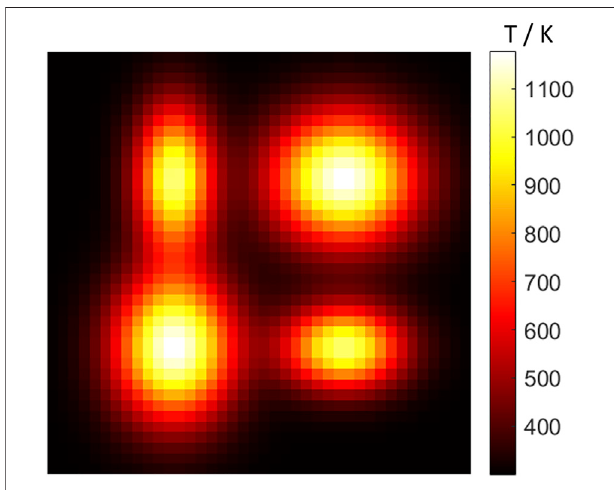
FIGURE 5 | The original temperature distribution of the 2D four- peak fl ame.